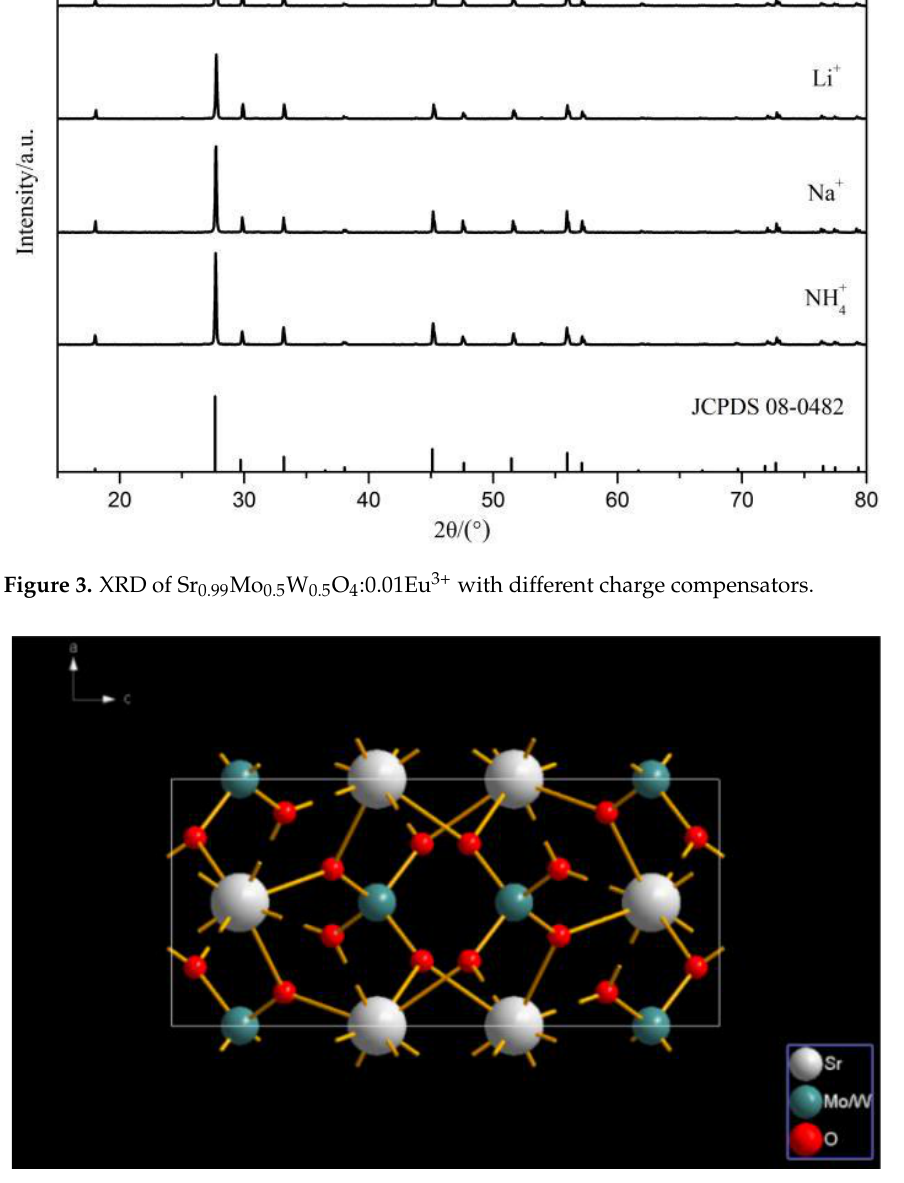
W O 0.5 0.5 4. W O was obtained by the KBr pressed W O surface sample. 0.5 0.5 4 0.5 0.5 4